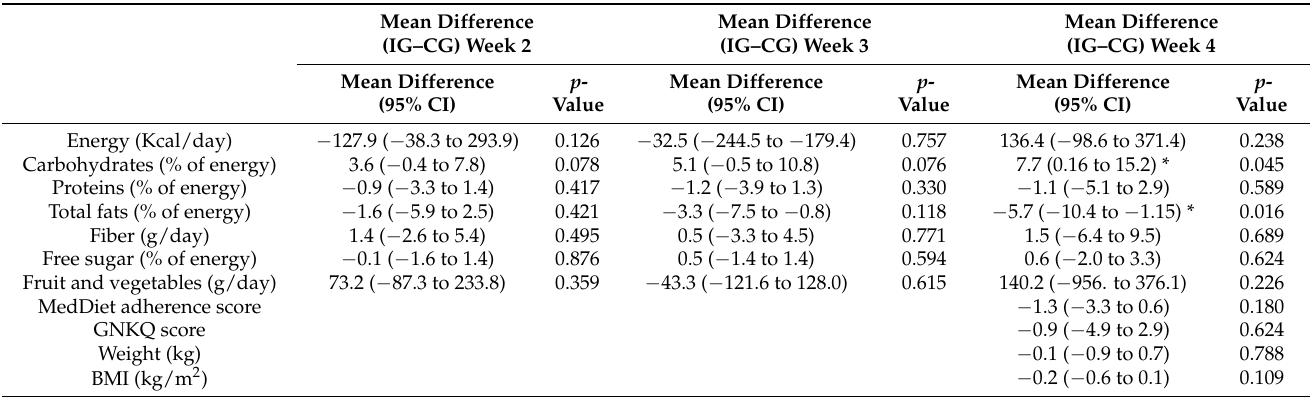
Table 3. SAlBi educa’s impact in terms of changes in macronutrient intake, adherence to MD, and nutritional knowledge over one